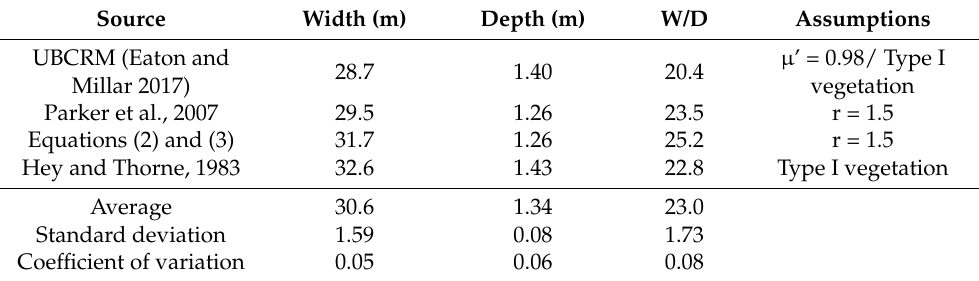
Table 1. Predicted bankfull width, depth and slope for the Merced River below Crocker-Huffman Dam in California, USA using Equations (2) and (3) in this paper, the University of British Columbia regime model (UBCRM, [65]) and relationships by Parker et al. [103], Hey and Thorne [85]. Input scaling variables are Q bf = 59.5 m 3 /s, D 50 = 0.032 m, S = 0.002. Source Width (m) Depth (m) W/D Assumptions